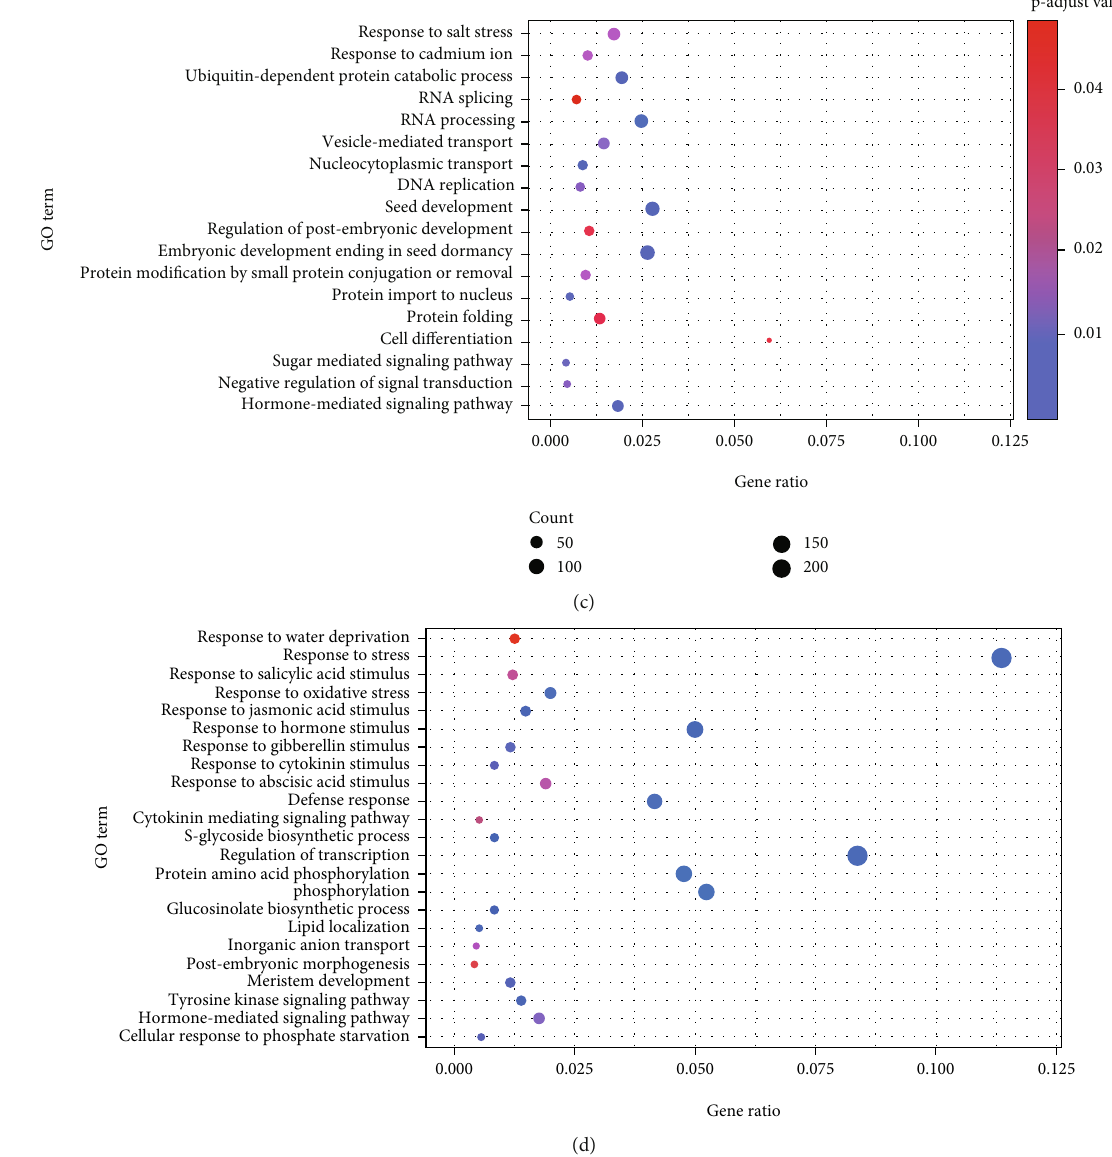
Figure 5: Functional enrichment analysis of the stage-speci fi c modules. (a) – (d) represent the signi fi cantly enriched GO terms ( p value < 0.05) in modules speci fi cally associated with stages I – IV,